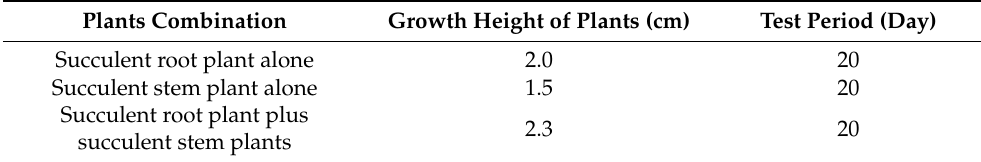
Table 5. Plant growth in each test